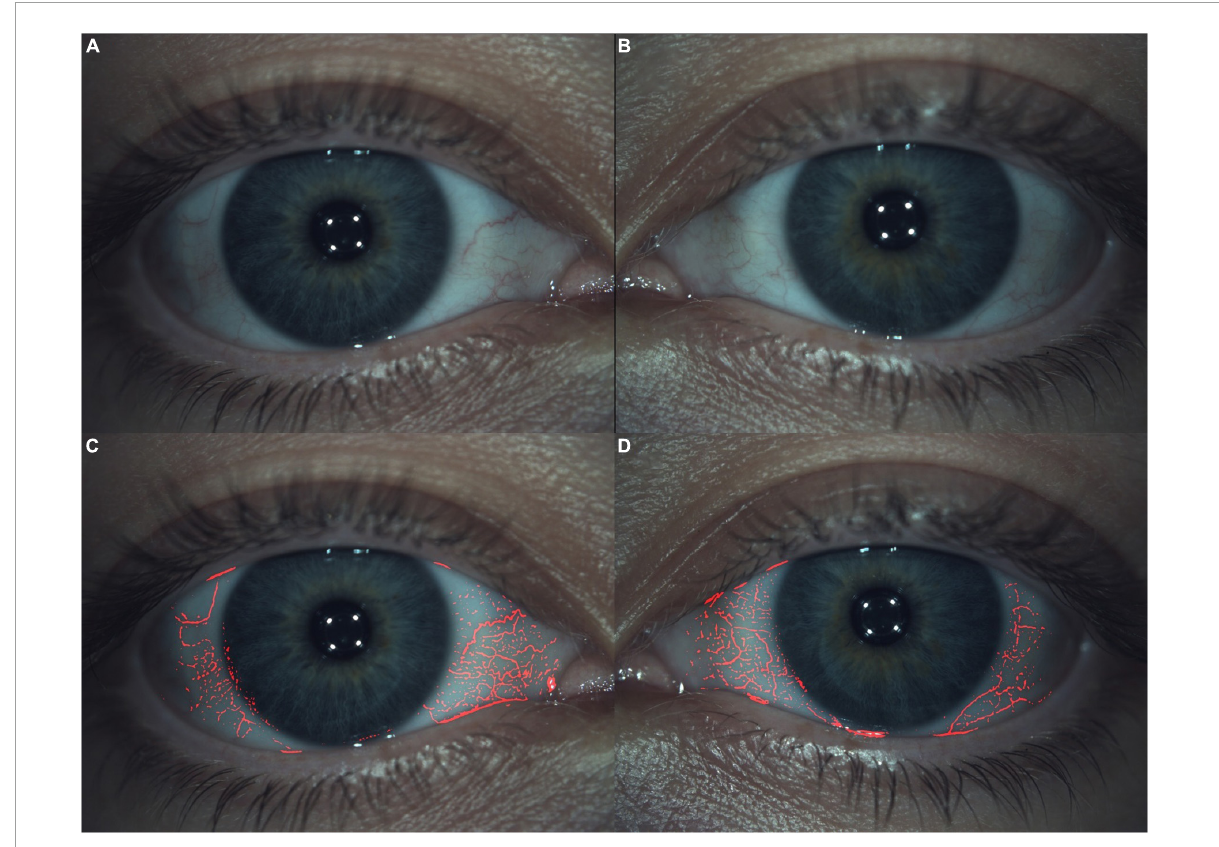
FIGURE2 Limbal and bulbar redness classification. All presented images are Grade 1 within the Efron Scale. (A,B) Right and left eye, respectively, with blood vessels fluidity of conjunctiva switch off. (C,D) The same right and left eye, respectively, with blood vessels fluidity of conjunctiva switch